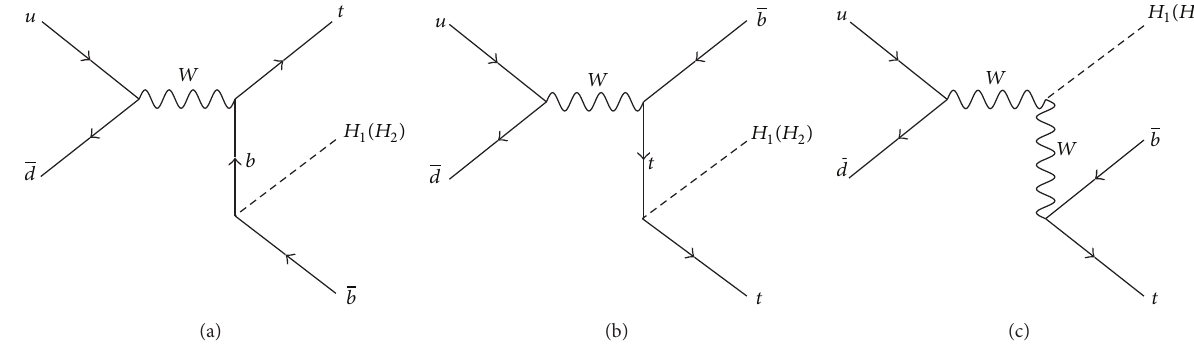
Figure 2: Lowest-order Feynman diagrams for 𝑝𝑝 → 𝑡𝐻 1 (𝐻 2 )𝑏 in the 𝑈(1) 𝐵